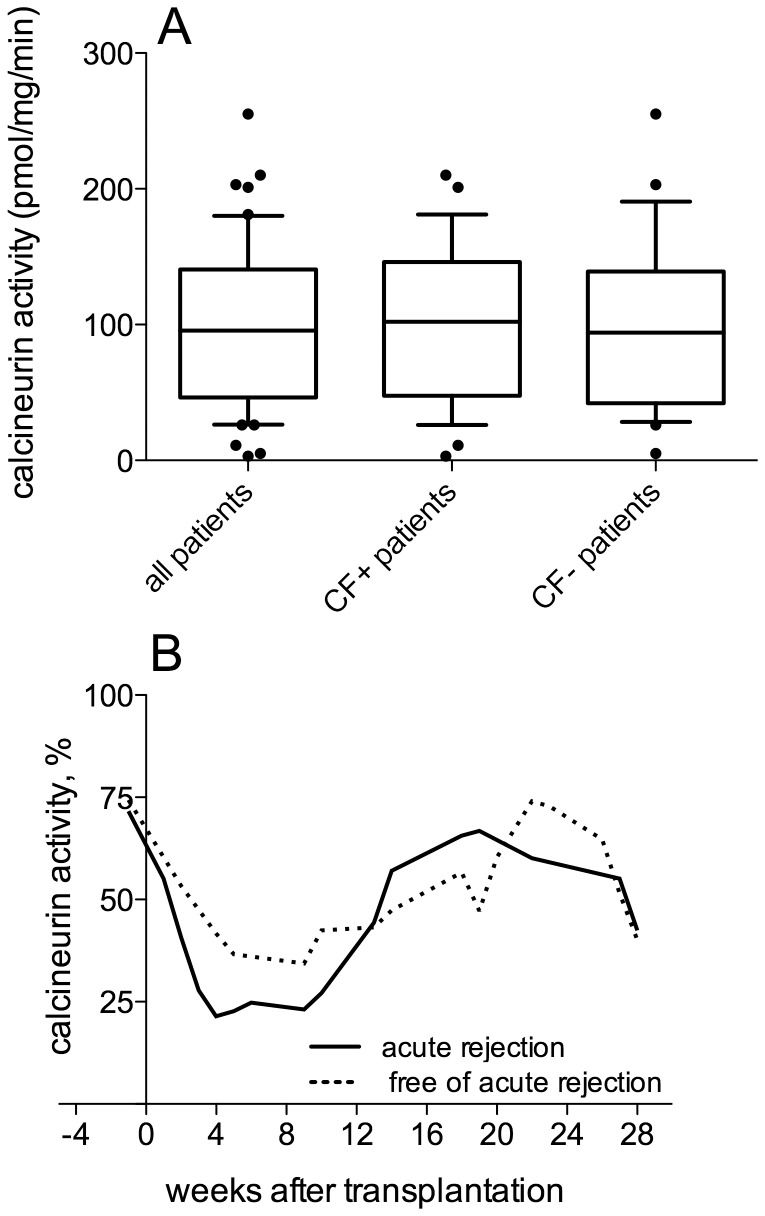
Calcineurin activity and acute rejection.(A) Calcineurin activity (CN-a) was measured before lung transplantation in 52 of the 107 patients enrolled in the participating center. The results are presented as box plots and 10–90 percentile whiskers. We compared CN-a expression prior to transplantation in patients with or without cystic fibrosis (CF) since it is the main initial end-stage lung disease that led to lung transplantation in this cohort of patients and a similar dispersion of the CN-a values was found in CF+ and CF- patients (p = 0.77, Mann-Whitney test). Subsequently, a relationship between extreme values of calcineurin activity and acute rejection was investigated. (B) Comparison across time of the median CN-a levels in patients displaying or not acute rejection: Kernel smoothing curves were generated. The 2 groups of patients displayed similar profiles of CN-a which consist of a phase of enzyme inhibition within the first 10 weeks after transplantation followed by a phase in which enzyme activity is restored. The phase of CN-a inhibition tended to be faster and more marked in patients who had developed acute rejection as compared to patients who were free of acute rejection. Similarly, the increase of enzyme activity to baseline levels tended to be faster and more pronounced in patients who had developed acute rejection.